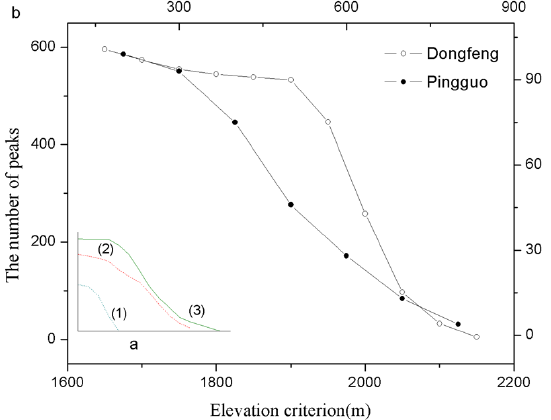
Figure 12. ( a ) Relationship between the height standards and Karst development stages (From Figure 2b). ( b ) Karst development phrase of the Pingguo System and Dongfeng System.